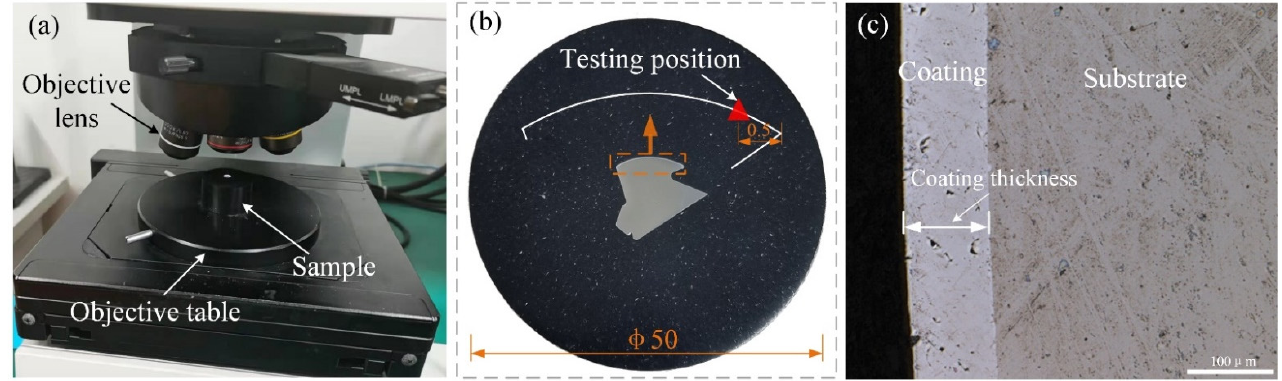
Figure 11. Wear area testing: ( a ) wear area; and ( b ) change curve of the wear area.